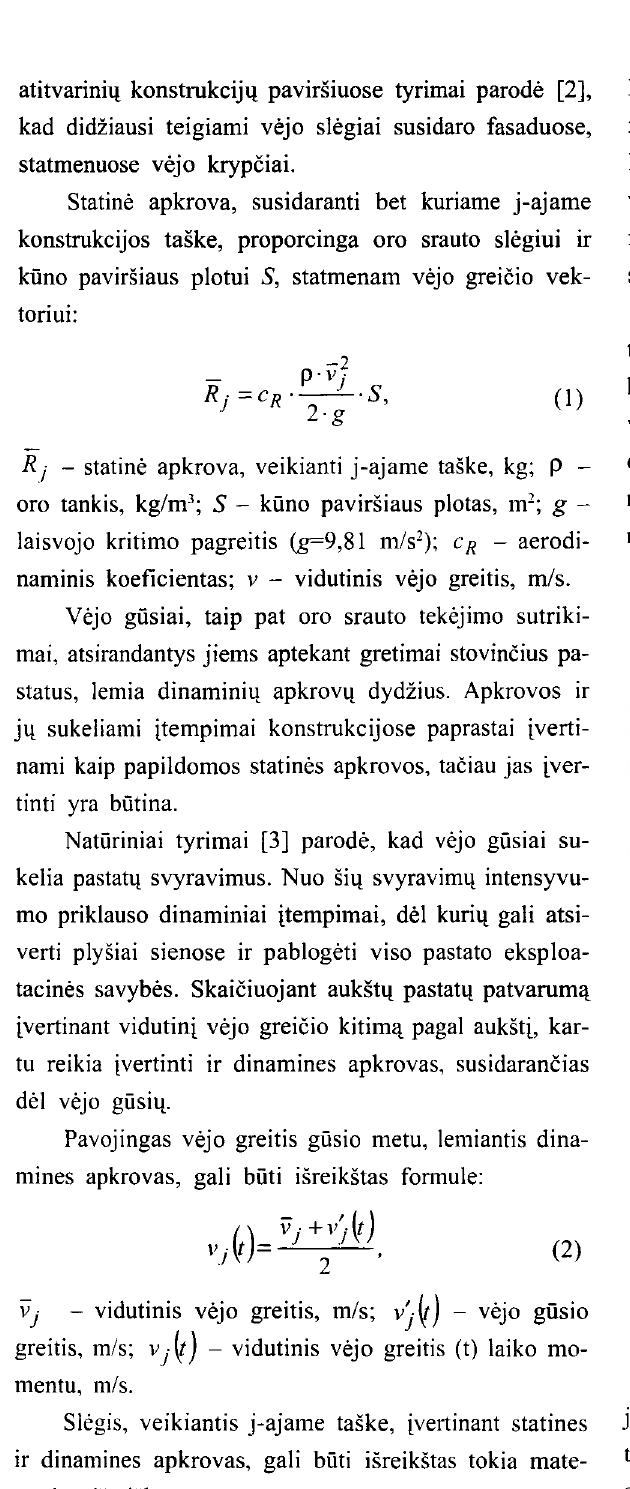
Fig 1. Dependence of moisture content in sand-lime brick with chipped off surface on cement-lime mortar due to wind